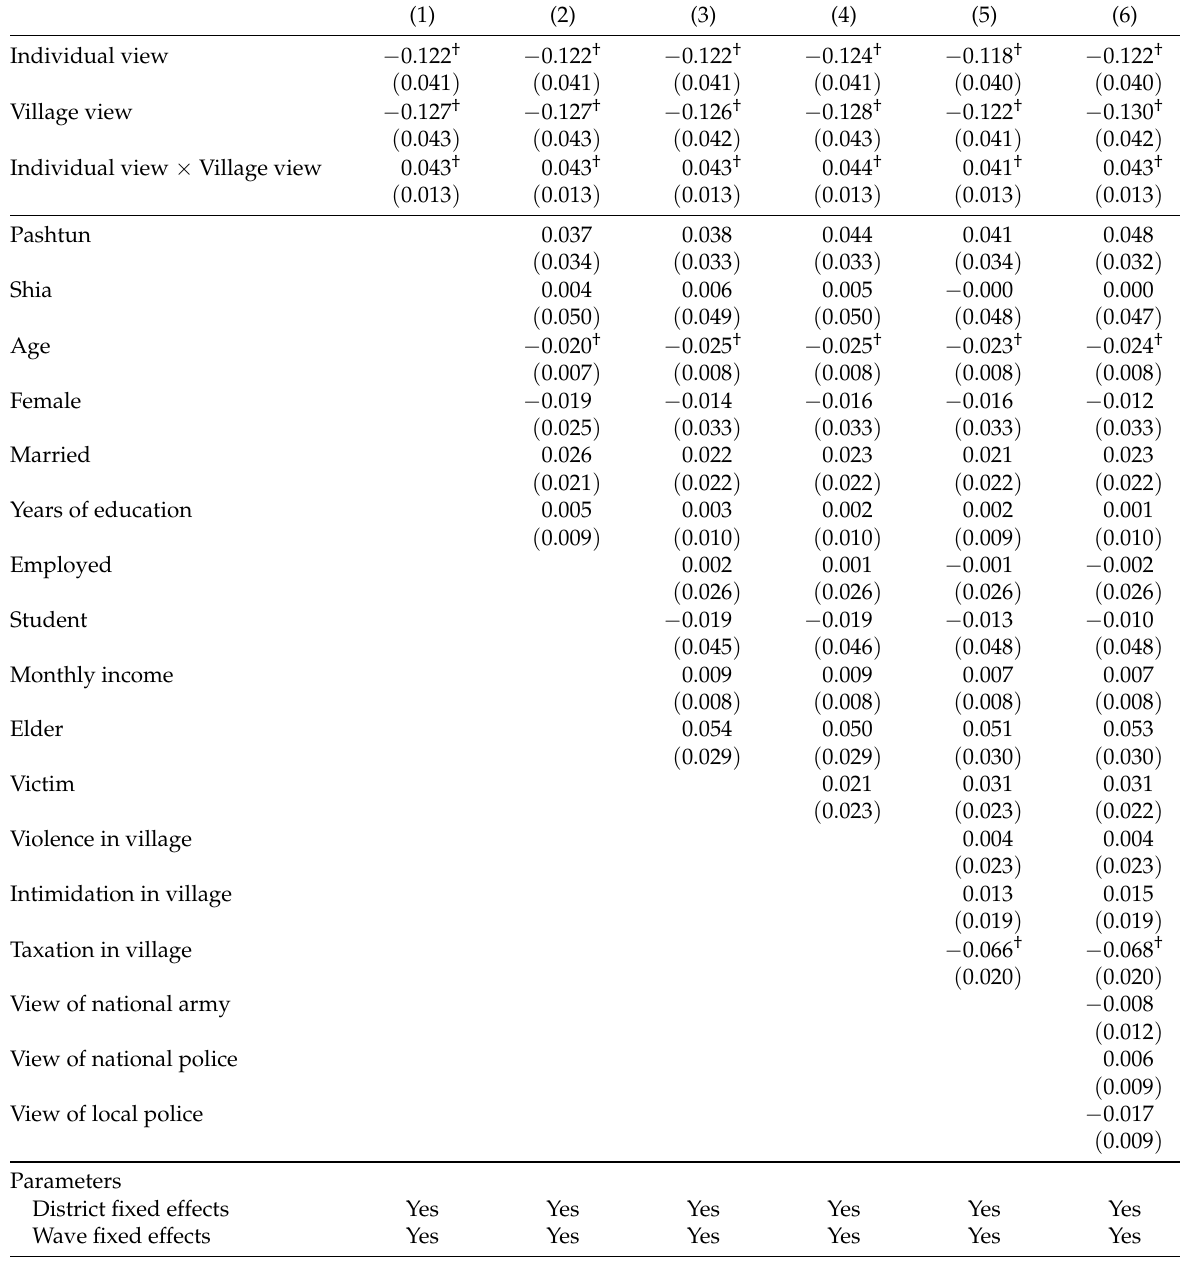
Table 2: Association between individual and village views of the Taliban and whether individual reports